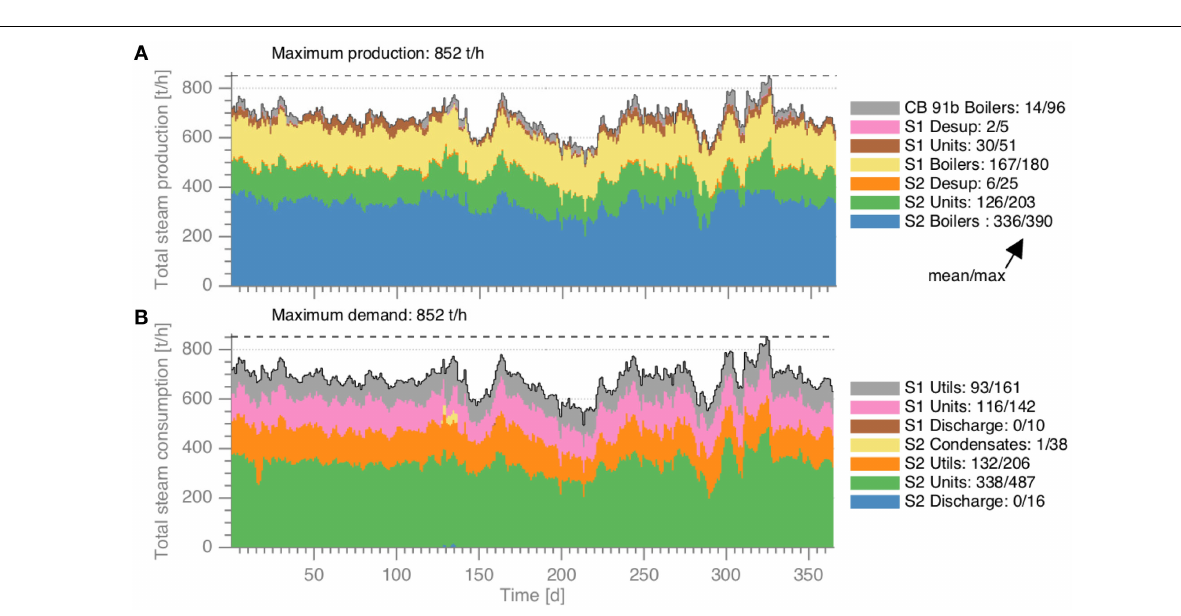
figuration 1 leads to the highest investment costs. The lowest operational costs occur in Configurations 3 and 4, as the use of the synergy lines allows the sites to make use of each others cheaper steam rather than the more expensive steam from the new